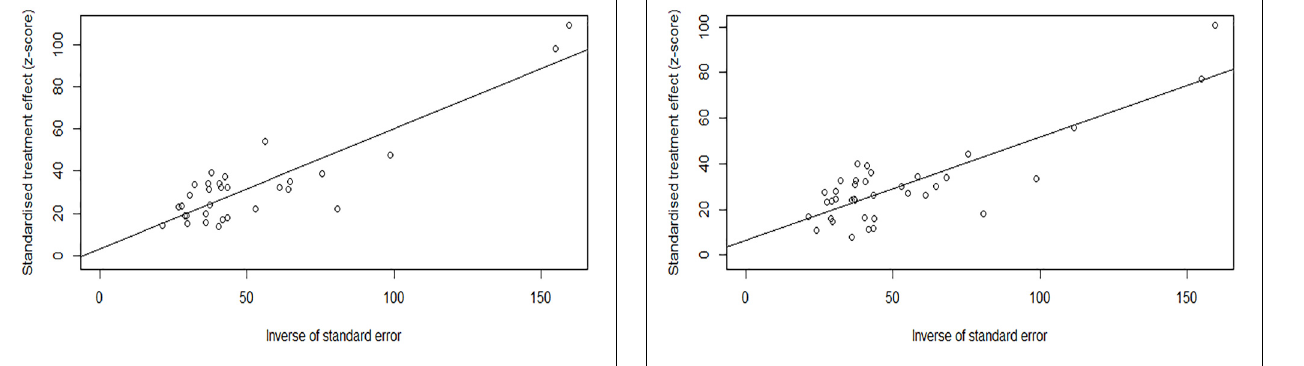
FIGURE 8 | Egger’s regression test for depression. FIGURE 9 | Egger’s regression test for